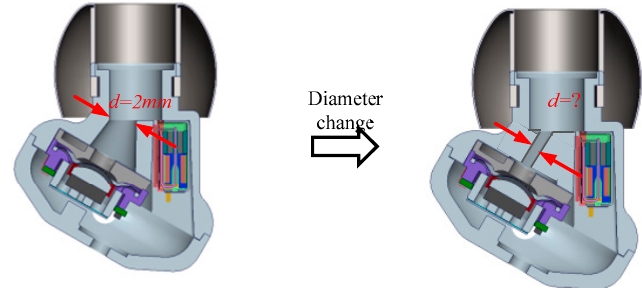
Figure 16. Acoustic tube diameter definition.